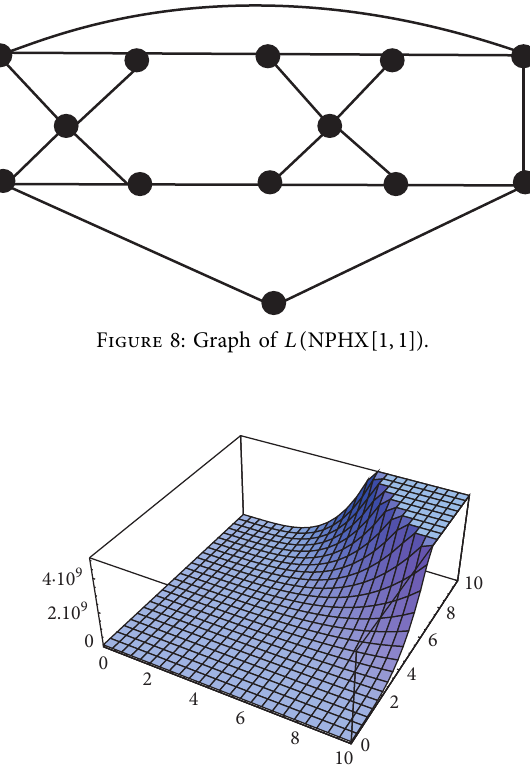
Figure 9: M-Polynomial of line graph of H-naphtalenic nanotubes ( L ( NPHX [ x, y ])